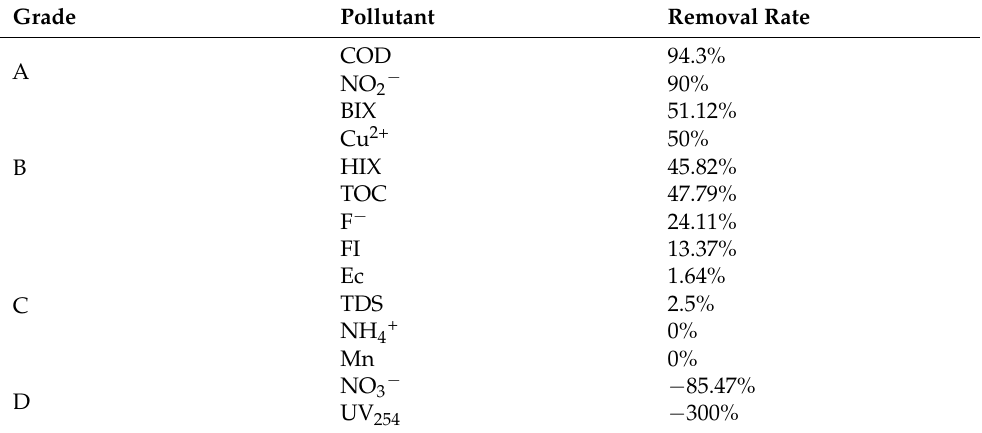
Table 2. Classification of treatment capacity of different pollution factors in the Caojiatan mine water treatment